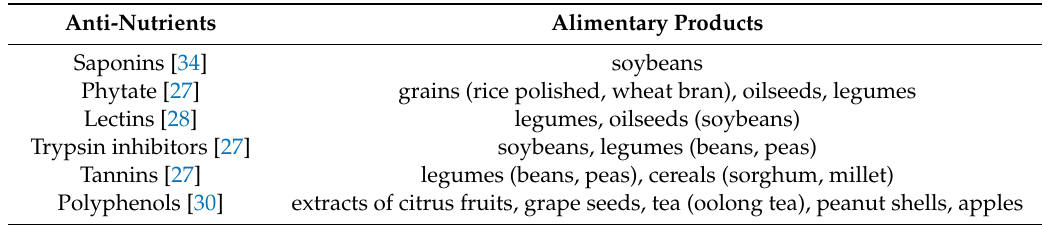
Table 1. Main anti-nutrients acting as inhibitors of pancreatic enzymes and their food source.